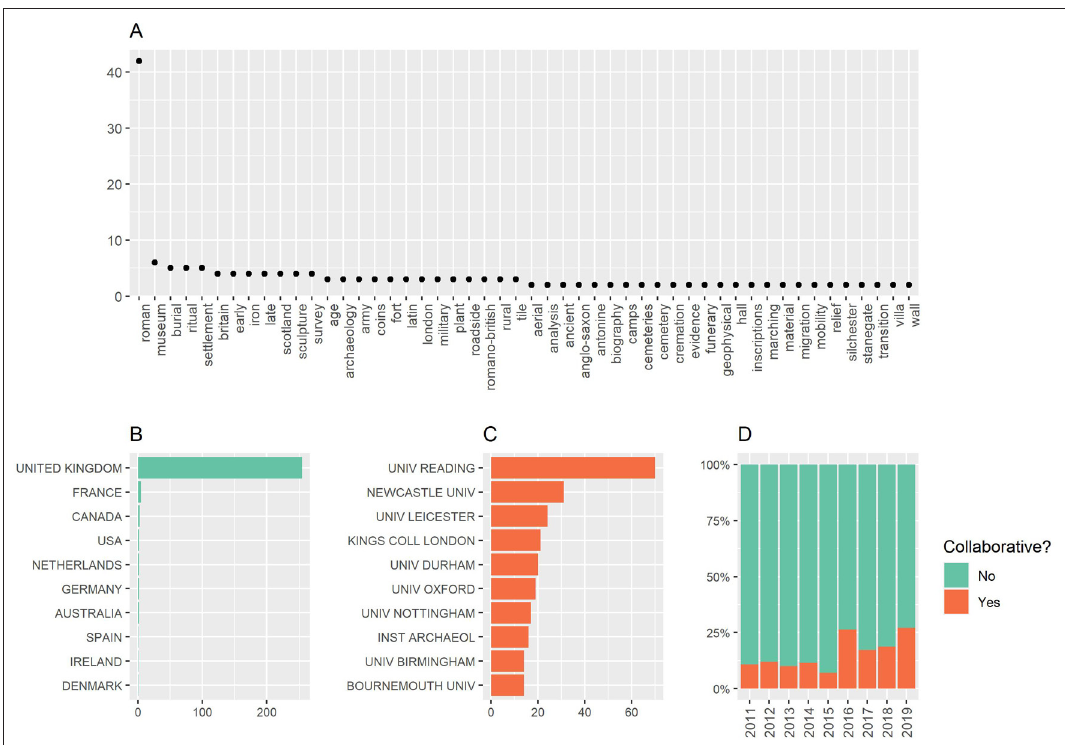
Figure 13: Britannia journal summary plot ( a : word frequency from article titles, b : institution country top ten, c : author institution top ten, d : single vs multi-author over